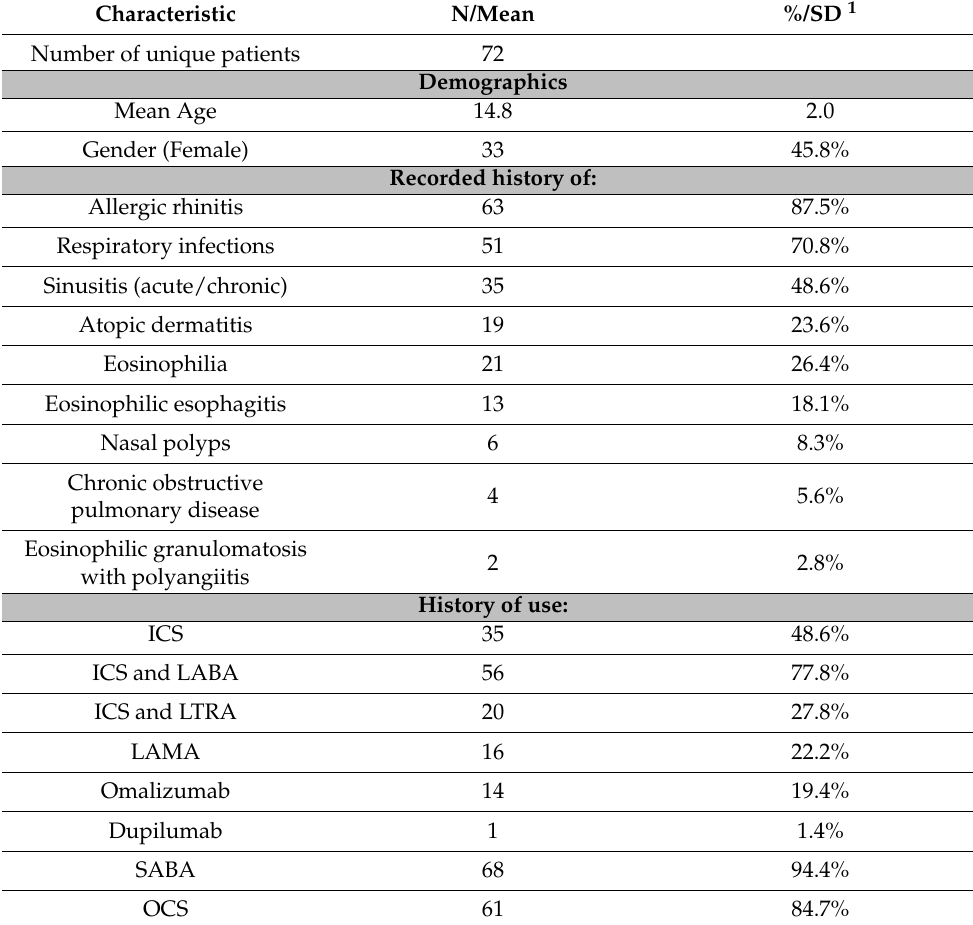
Table 1. Baseline demographic and clinical characteristics of new mepolizumab users <18